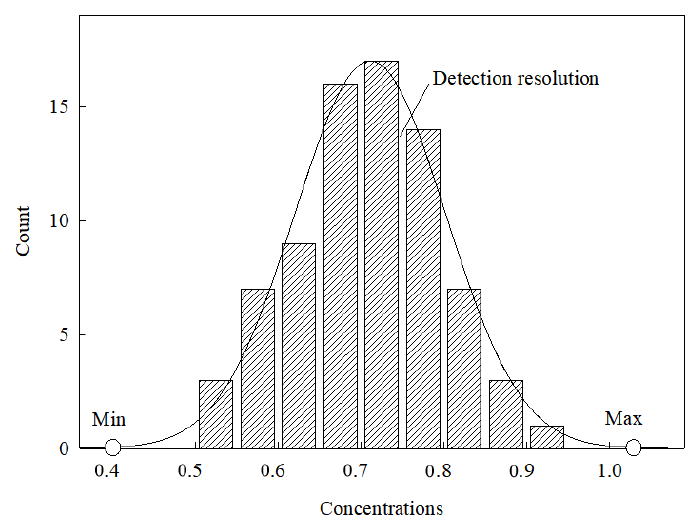
Figure 1. The concept map of the parameters for evaluating spectral models.